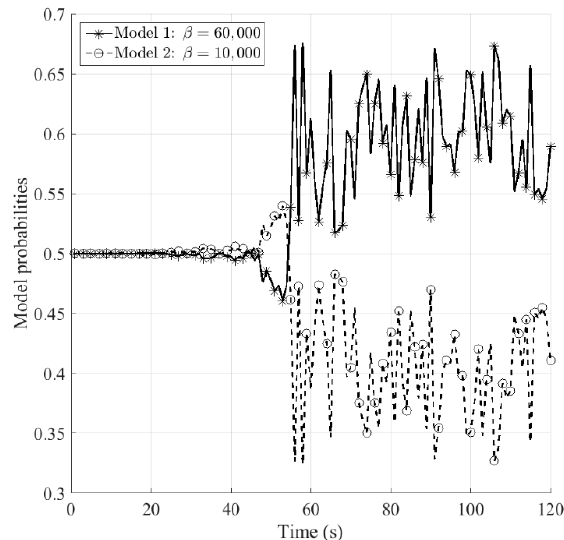
Figure 7. Model probabilities for sensor S 1 .